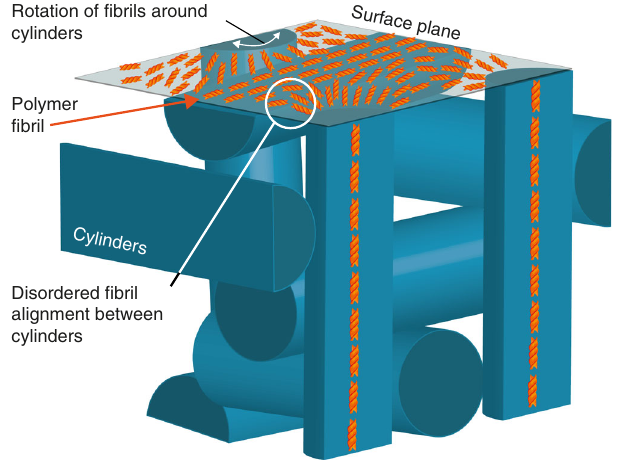
Fig. 6 Schematic of the molecular model for non-aligned ACPCA thin fi lms. A representation of the proposed double twist cylinder blue phase in annealed, non-aligned ACPCA